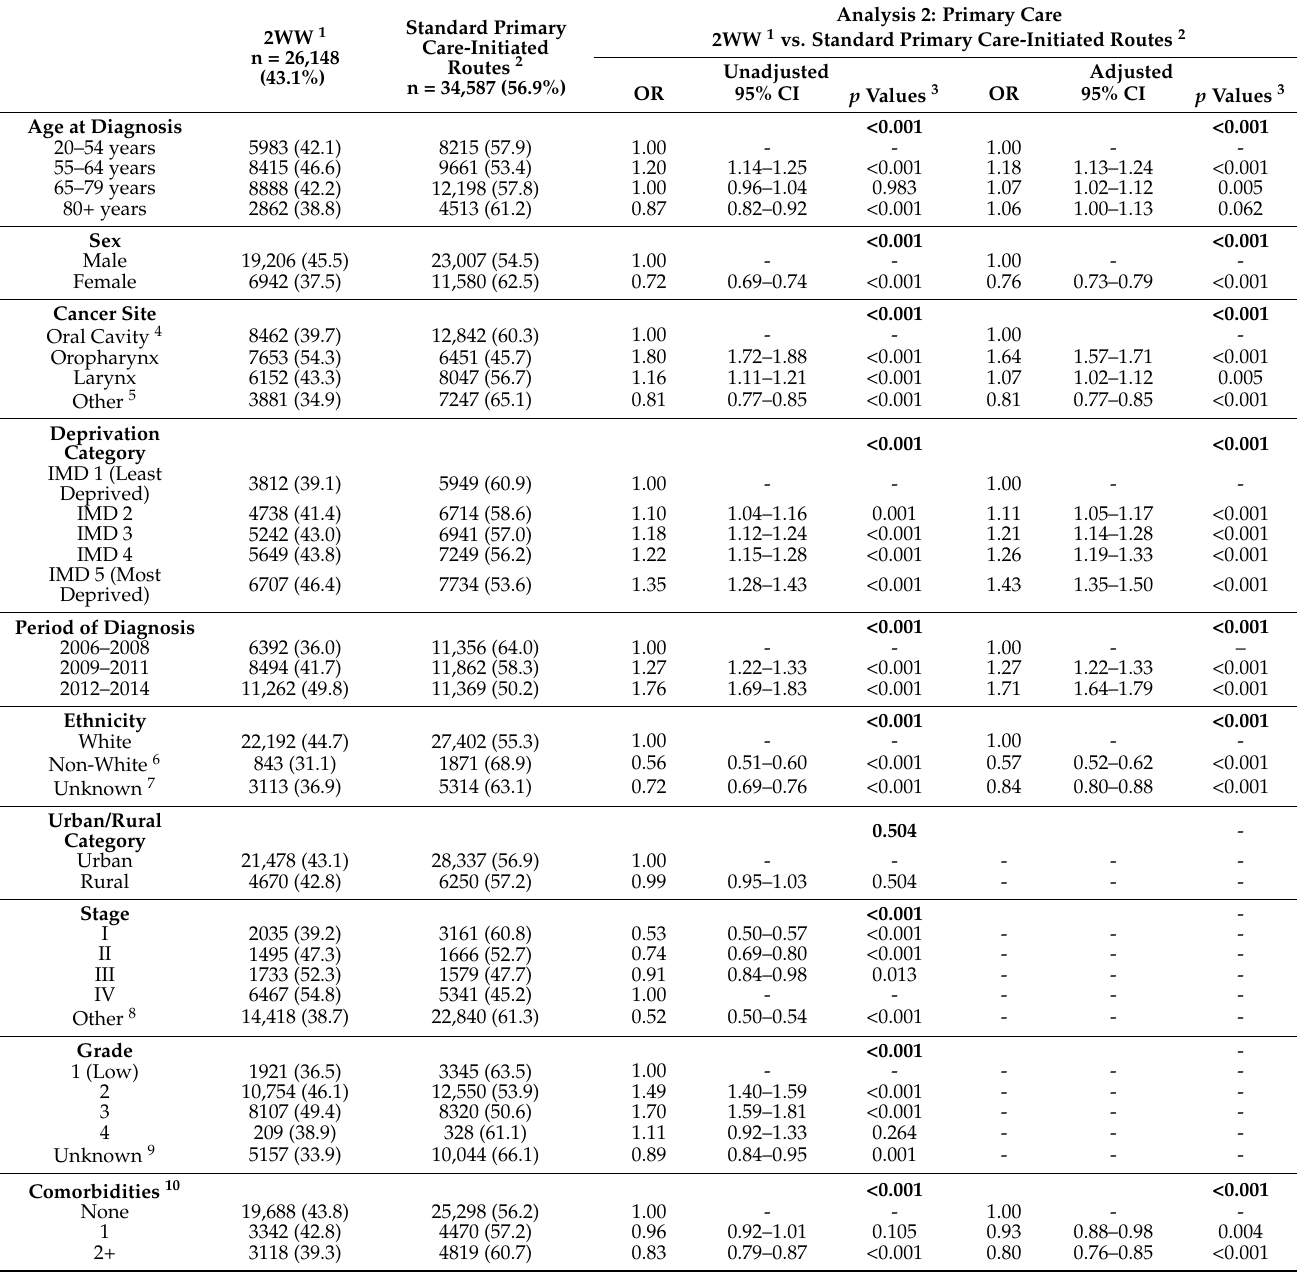
Table 3. Likelihood (OR, 95% CI and p values) from logistic regression of 2WW versus stan- dard primary care-initiated routes by socio-demographic and clinical characteristics for Analysis 2 (n =